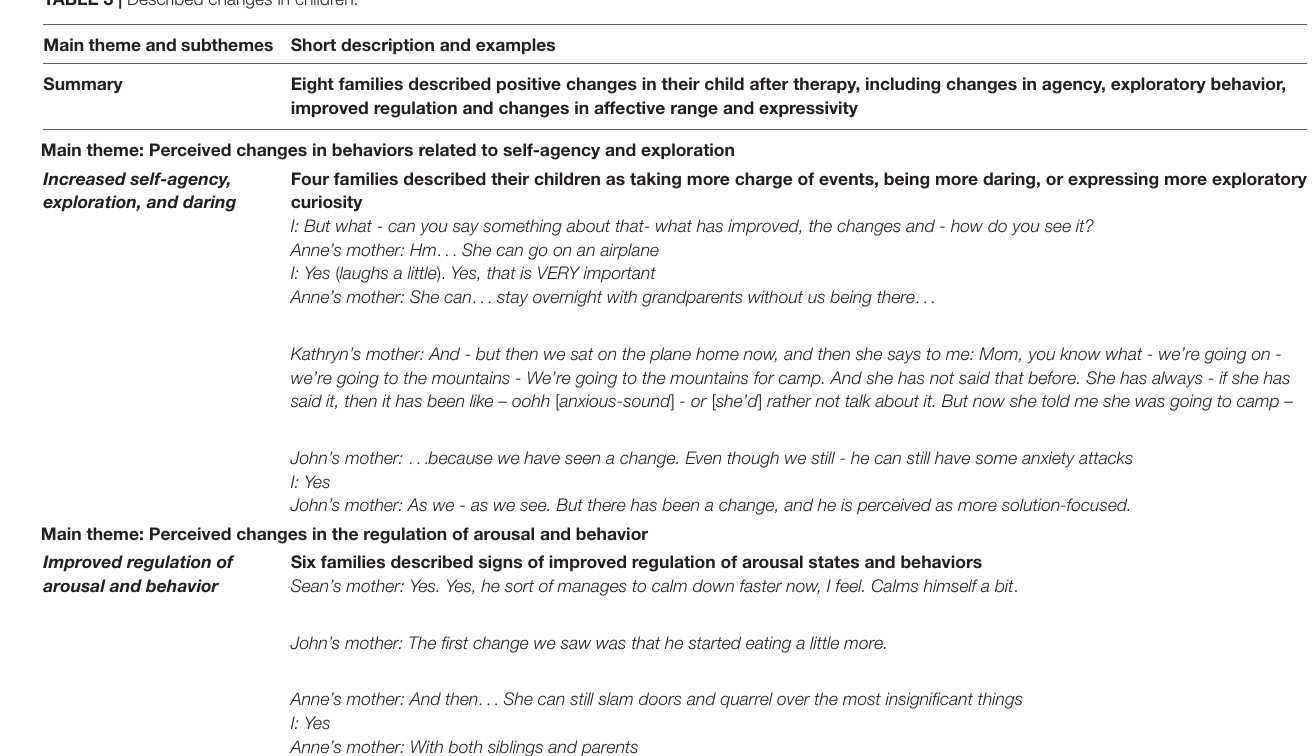
TABLE 3 | Described changes in children.